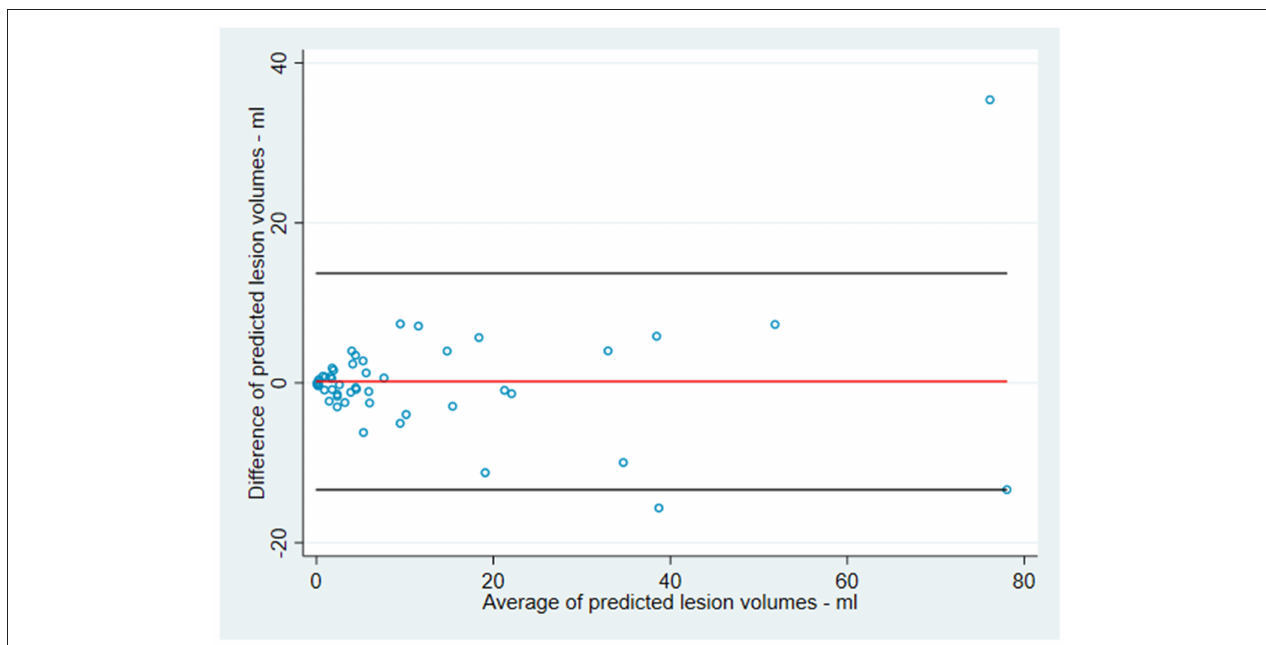
FIGURE 2 | Interaction of infarct size and prediction. Bland Altman plot depicting the predicted volume of follow-up lesions plotted as the difference between the two predictions (theophylline and placebo) over the average of the two predicted volumes for each patient: Values < 0 indicate that theophylline is better than placebo while values > 0 indicate that placebo is better than theophylline: Middle line indicates mean difference between the predicted values, upper and lower line indicates the higher and lower limit of agreement (2x standard deviation) indicating no significant difference between small and large infarct volumes.